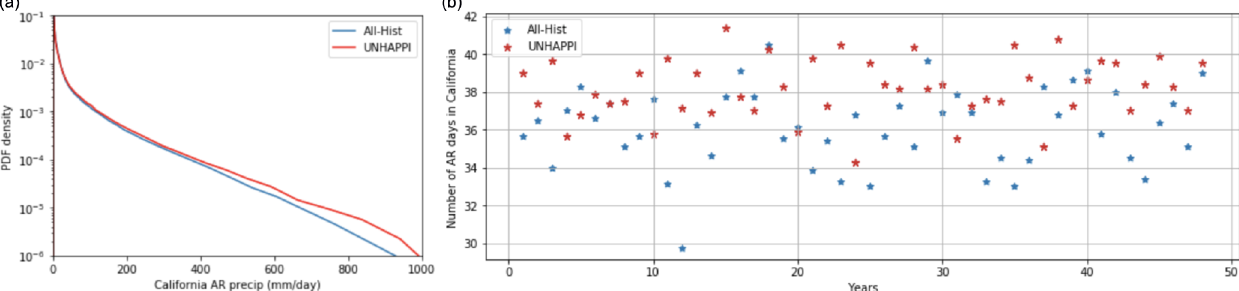
Figure 12. (a) Conditional PDF of atmospheric river precipitation in California using fastKDE (O’Brien et al., 2016); (b) number of atmo- spheric river days annually in California, shown for 50 years of All-Hist and